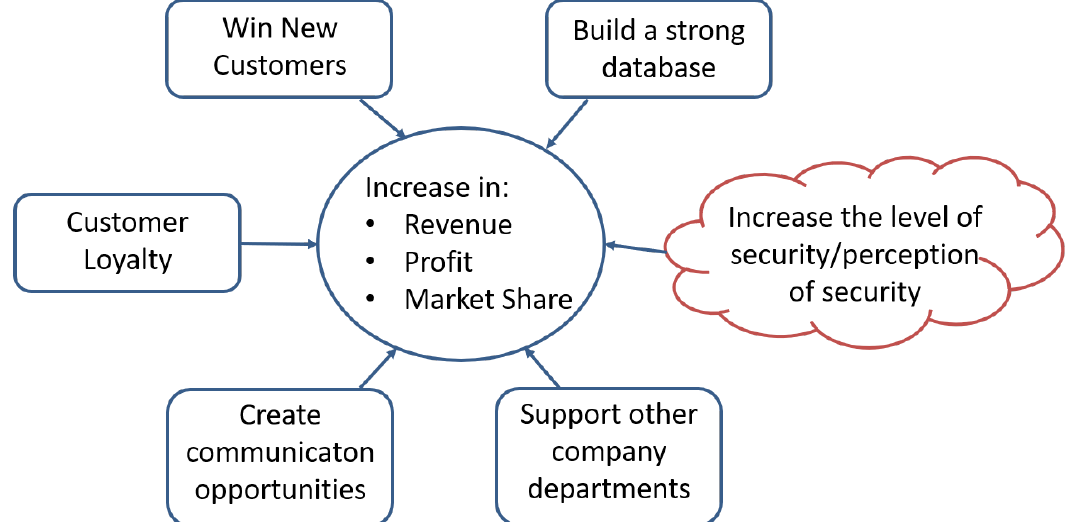
Figure 1. Main Goals of Customer Loyalty Programs, based on